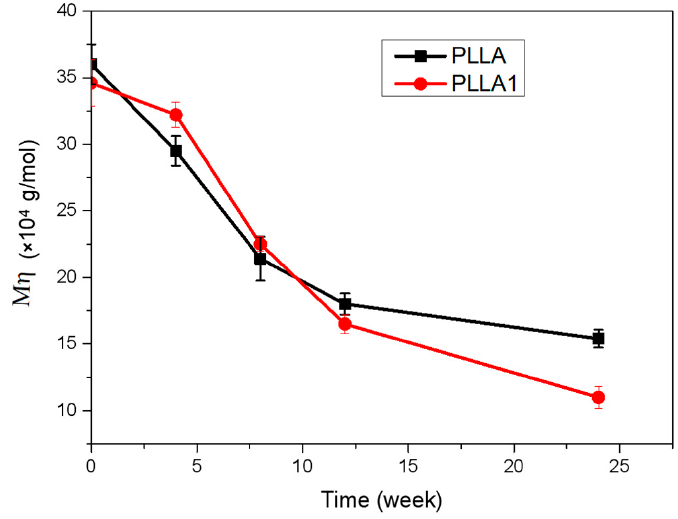
Figure 11. The weight average molecular weight ( M η ) of PLLA and PLLA1 in the rabbit body.